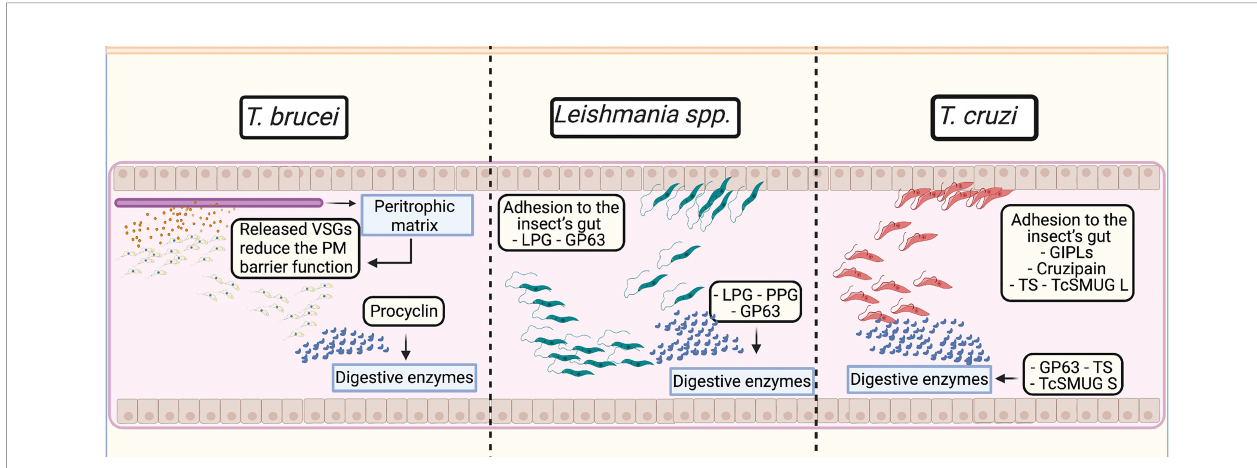
FIGURE 1 | Virulence factors roles in their insect vectors intestine tract. T. brucei : Variant surface glycoprotein (VSGs) released from the membrane are incorporated by the peritrophic matrix, reducing its protective function by interfering with the host cell internal pathways. Following VSG release, the surface coat is replaced by procyclins that may protect the parasite against digestive enzymes and hydrolases in the tsetse fl y midgut. Leishmania spp.: Inside the invertebrate vector intestines, lipophosphoglycans (LPGs) and gp63 ensure the parasite adhesion to the midgut epithelial cells and alongside proteophosphoglycans (PPGs), protect the parasite against the action of host digestive enzymes. T. cruzi : The parasite adhesion is performed by glycoinositolphospholipids (GIPLs), cruzipain, trans-sialidases (TS) and the mucin group TcSMUG L. The protection against the digestive enzymes may be performed by gp63 via its metalloprotease activity; TS may be involved in protection from glycolytic enzymes; and the mucin group TcSMUG S may perform roles of protease